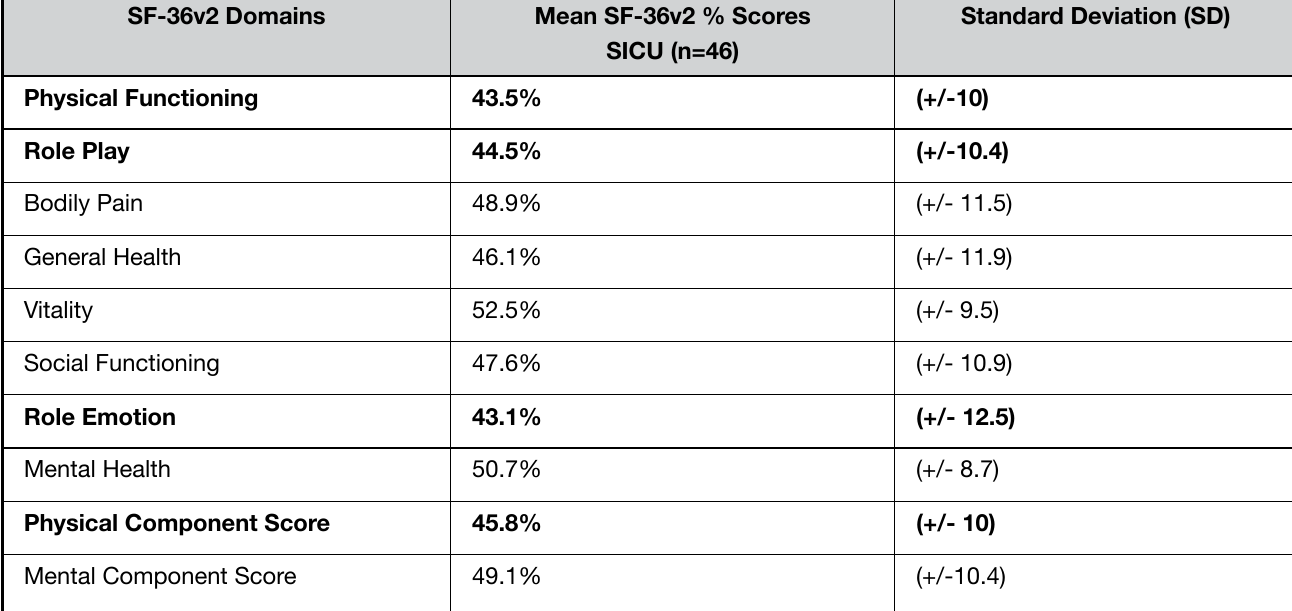
Table 2: Mean SF-36v2 hRQol domain scores (SD) of Sicu patients (n = 46) SF-36v2 Domains